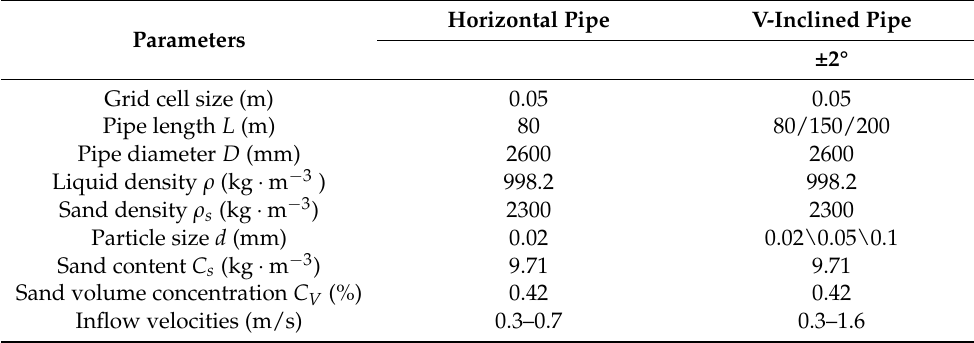
Table 2. Parameters under different simulation